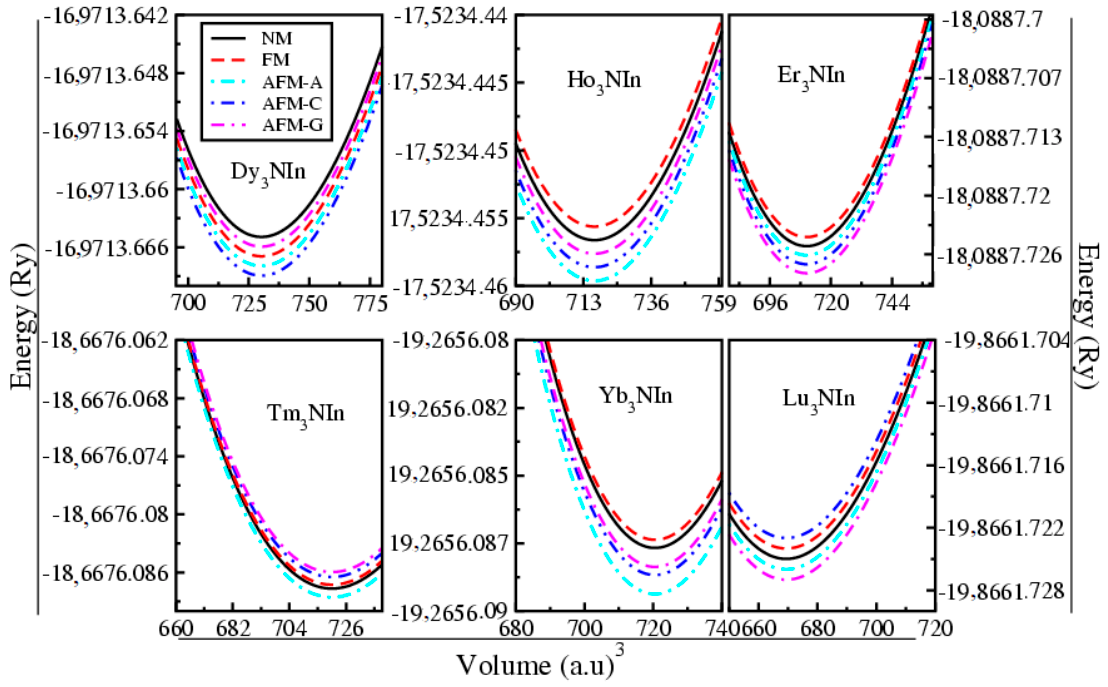
Figure 10. Stable magnetic phase optimizations of the rare earth nitrides Ln 3 NIn (Ln = Dy-Lu) anti-Perovskite.